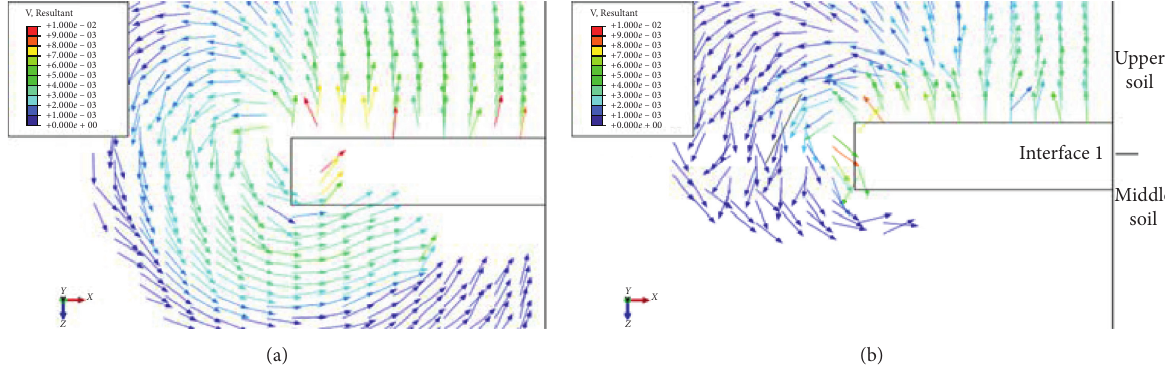
Figure 4: Soil flow under different formation conditions ( H � 6m). (a) Single-layer soil. (b) Layered